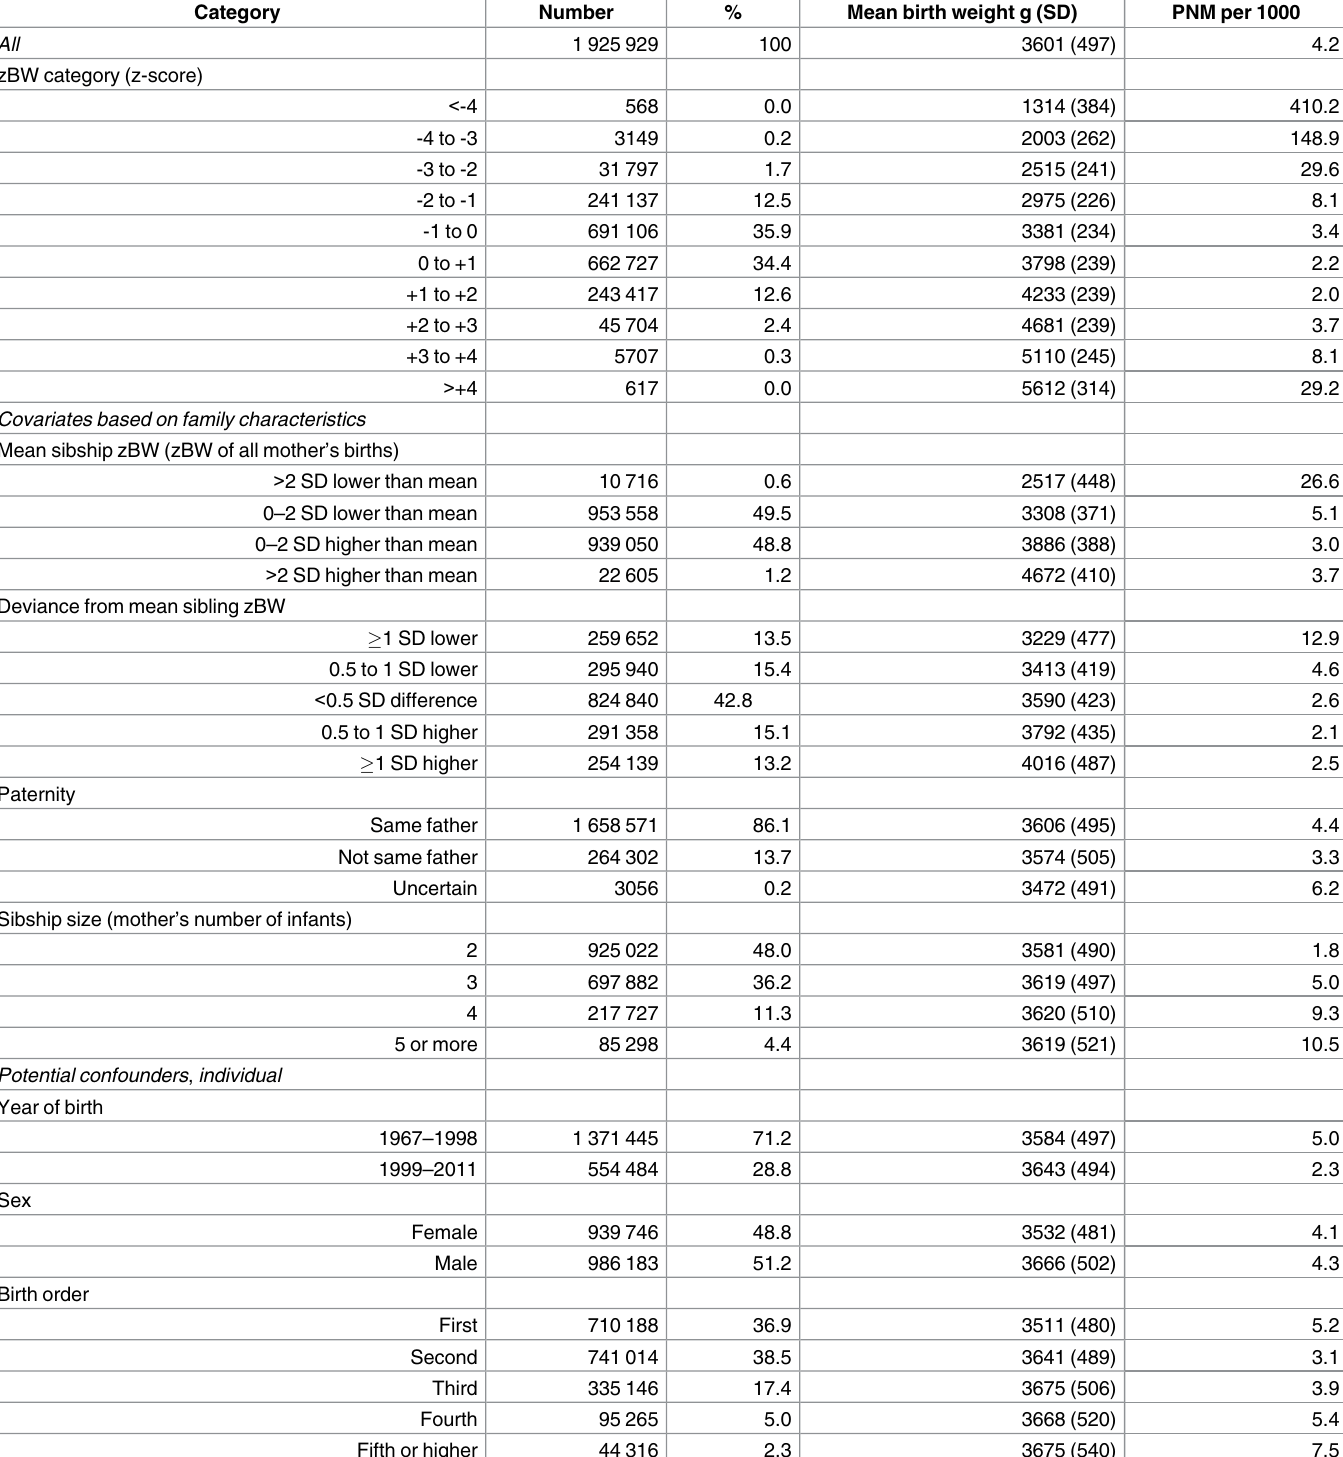
Table 2. Distribution of independent variables and their relations to birth weight and perinatal mortality: 1 925 929 infants born in Norway 1967–